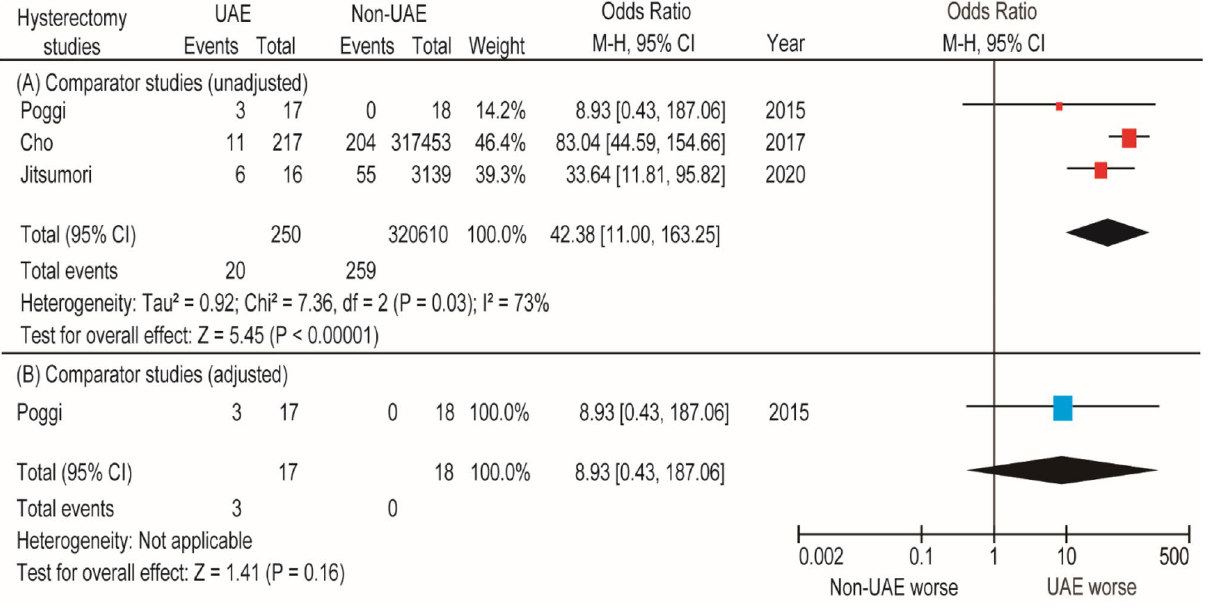
Figure 3. Results of the meta-analysis of the effect of prior UAE on the rate of hysterectomy. The pooled odds ratios of ( A ) hysterectomy and ( B ) hysterectomy with previous PPH for women who did and did not undergo prior UAE. Some values listed might be slightly different from the original values because the calculation was performed using Revman ver. 5.4.1. UAE uterine artery embolization, CI confidence interval, df degrees of